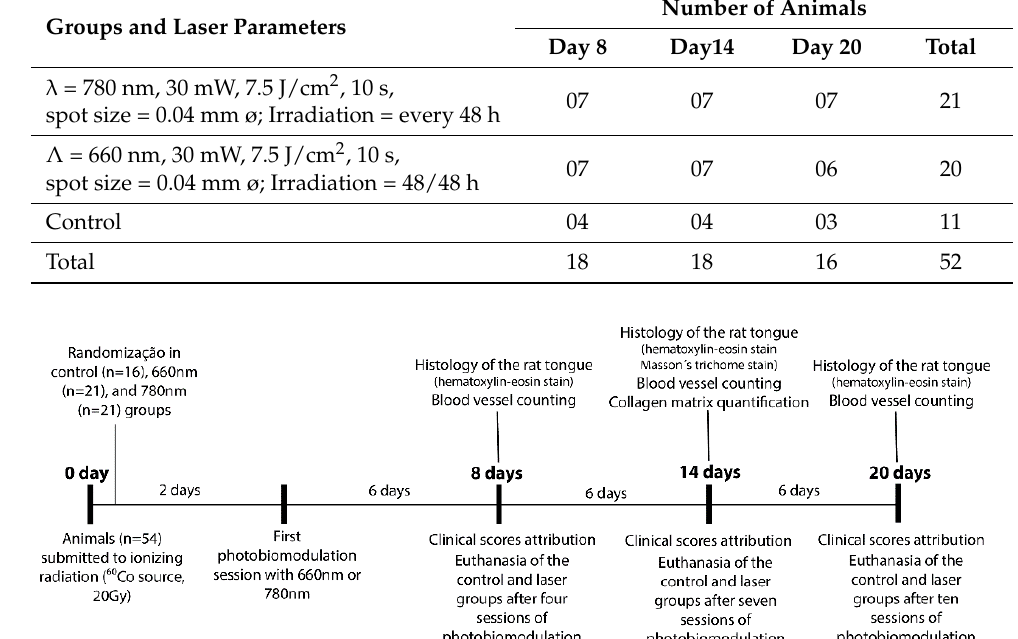
Figure 1. Study methodology in accordance with the experimental periods.